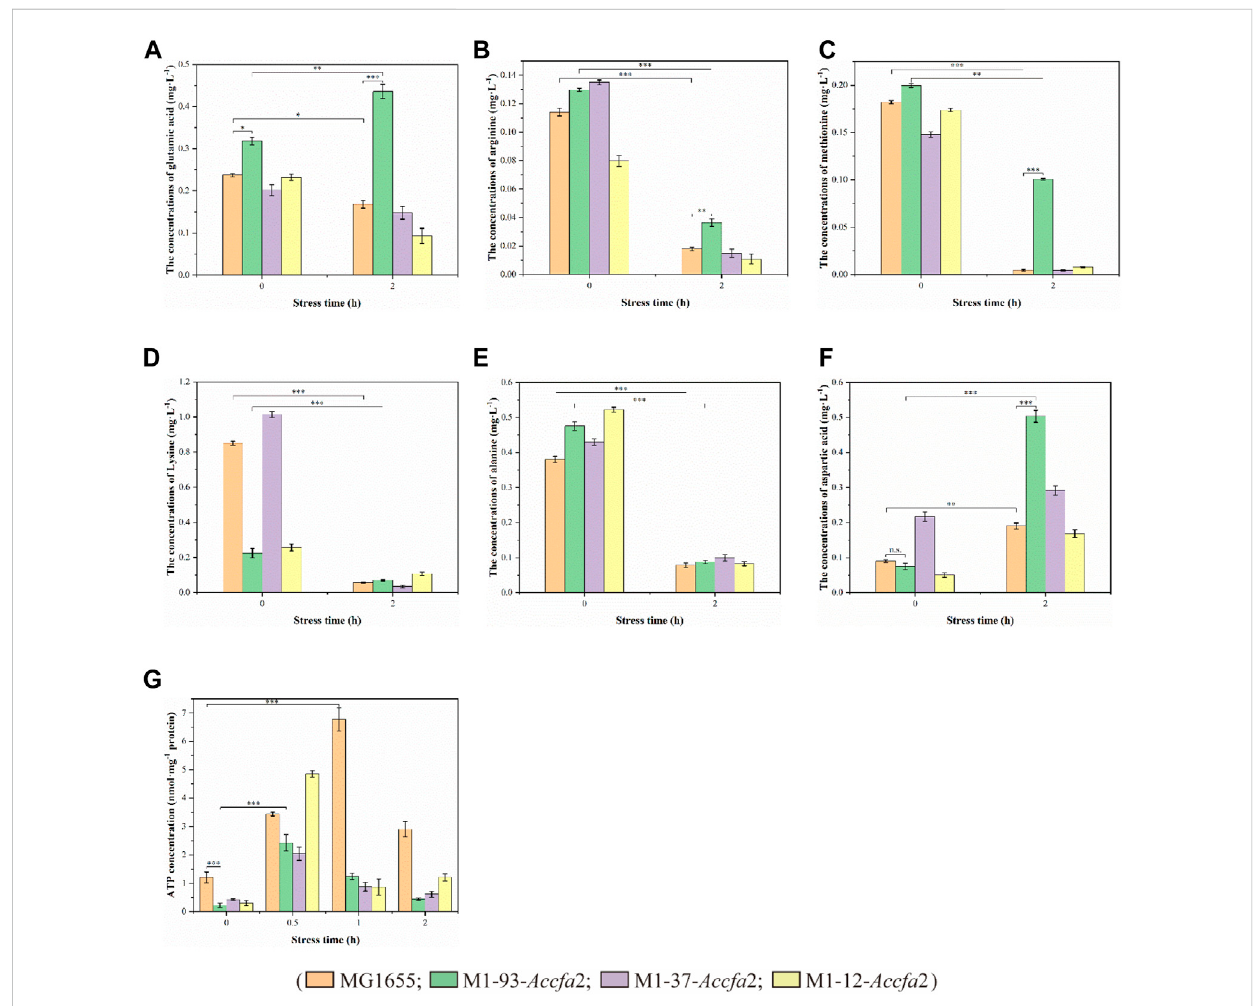
FIGURE 6 The physiological effects caused by the heterologous expression of Accfa 2 on the acid resistance mechanism of E. coli . (A – F) The alterations in the concentrations of intracellular glutamic acid, arginine, methionine, lysine, alanine and aspartic acid in the strains MG1655, M1-93- Accfa 2, M1-37- Accfa 2 and M1-12- Accfa 2 before and after exposure to acid stress, respectively. (G) The alteration in the concentrations of intracellular ATP in the strains mentioned